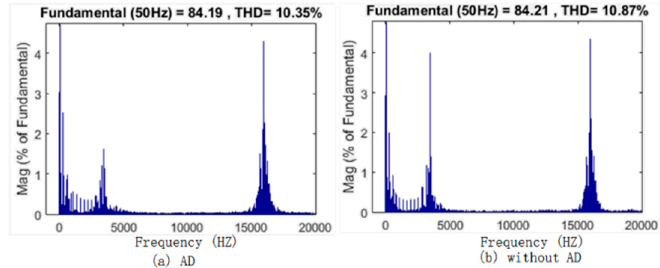
Figure 18. Waveform comparison of i o , i L , i g , and v c between AD and without AD under 80A i L.